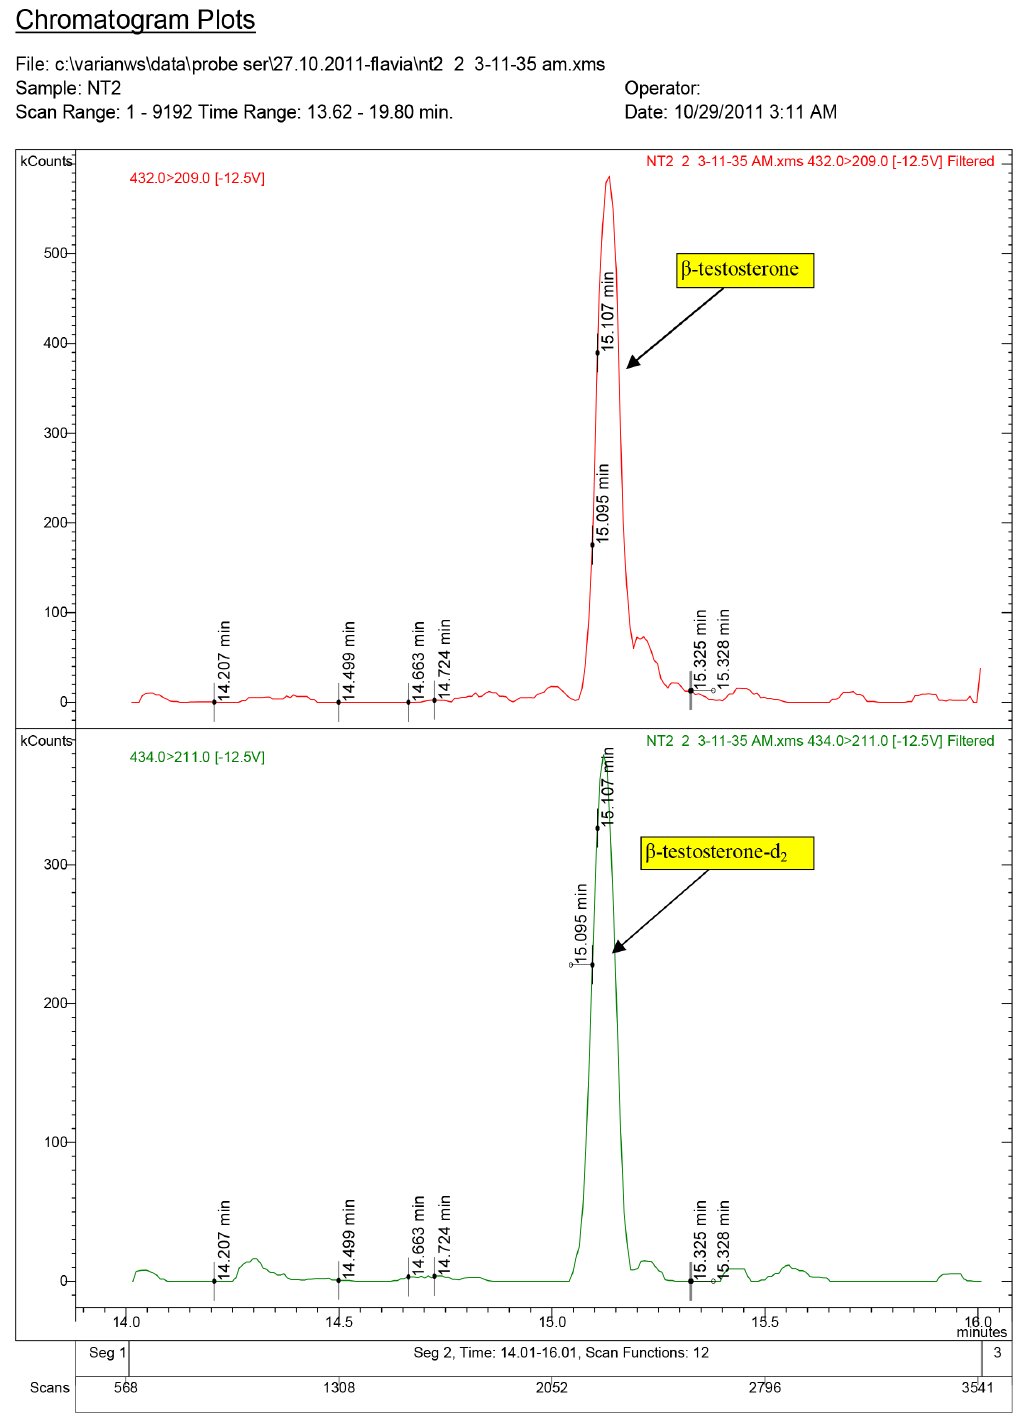
Figure 6. Diagnostic ions for serum sample NT2, where 17 b -testosterone was quantified at 2.29 ng/ml (group ND1, dose: 1.5 mg/ kg.bw).